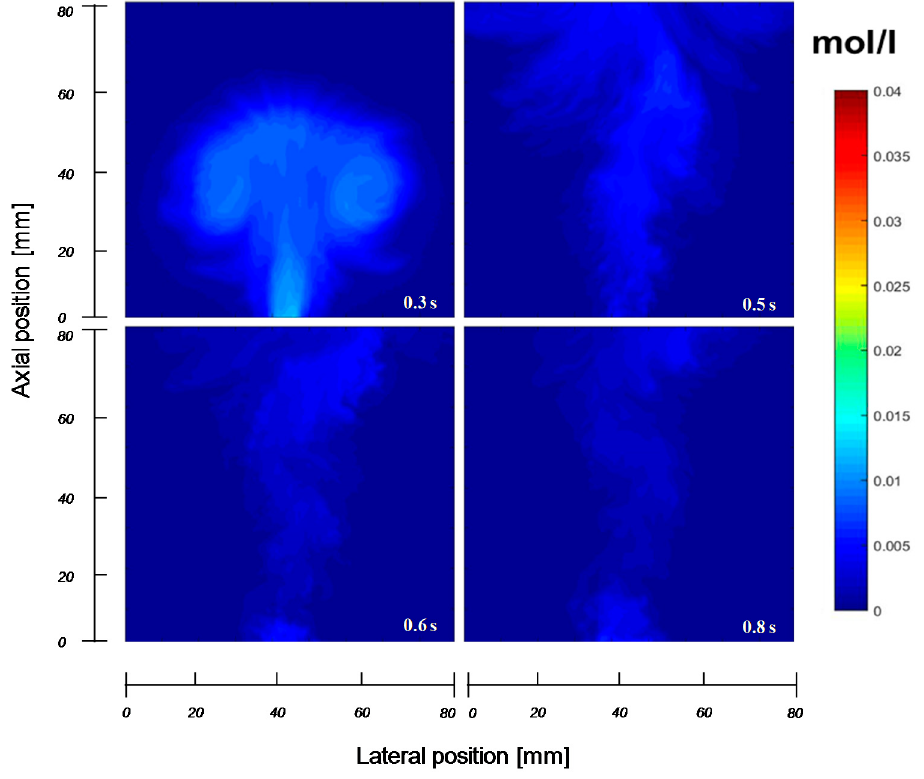
Figure 11. Tracer gas concentration profiles from gas injection into an empty column fed with N 2 as a function of time.